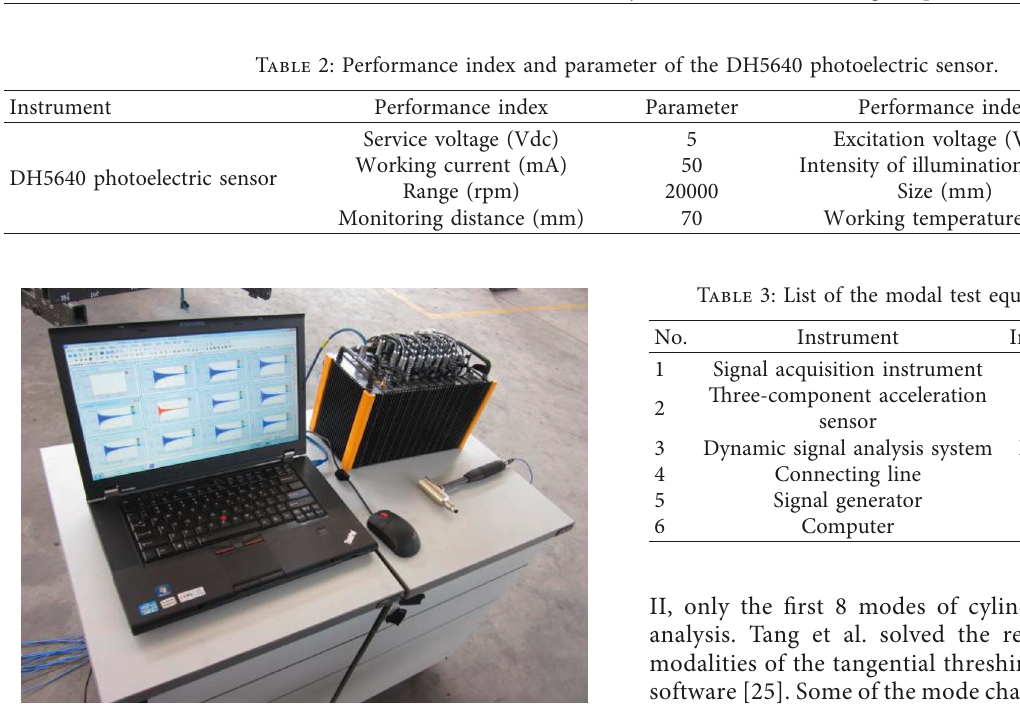
Figure 5: DH5902 dynamic signal acquisition instrument.